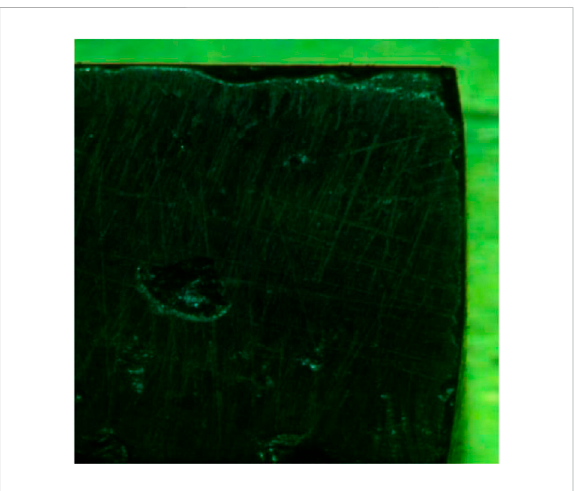
FIGURE 4 Real-Time State Image of Coal sample at a certain time.